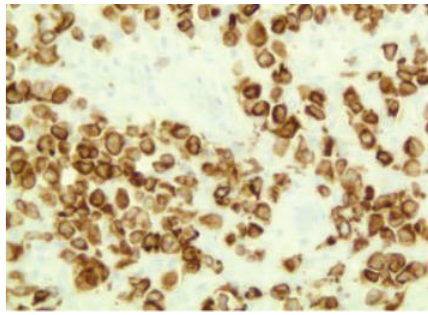
Figure 6: CD 20 positivity suggestive of DLCBL (100x).